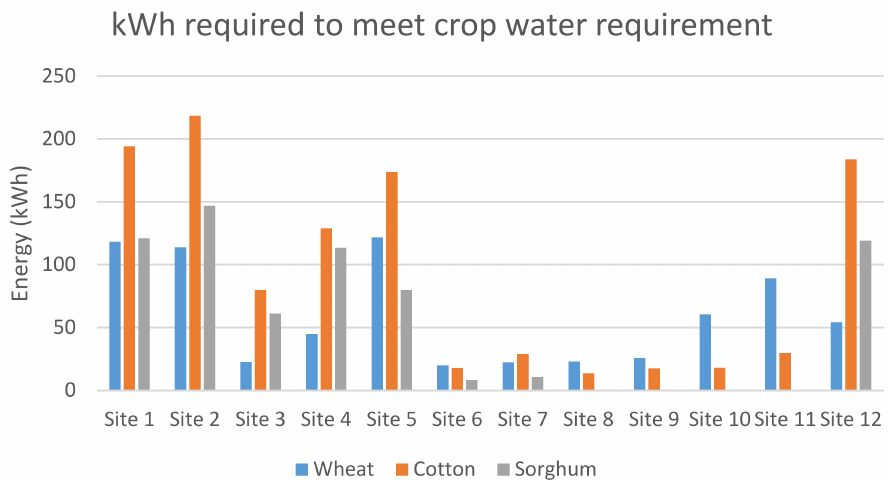
Figure 19. Energy required at each site to meet crop water